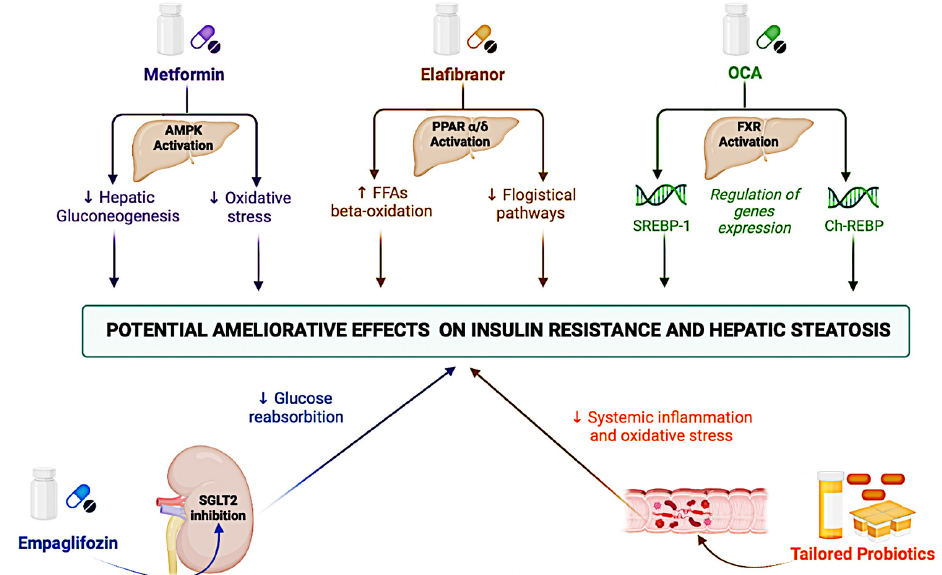
Figure 3. Principal mechanisms of action of therapies currently undergoing clinical studies for ameliorating IR-related hepatic steatosis. AMPK: AMP-activated protein kinase; ChREBP: Carbohydrate Response Element Binding Protein; FXR: Farnesoid X receptor; FFAs: Free Fatty Acids; IR: Insulin resistance; OCA: obeticholic acid; PPAR: Peroxisome proliferator-activated receptor; SGLT2: Sodium-glucose transporter 2; and SREBP-1: Sterol regulatory element-binding protein 1.